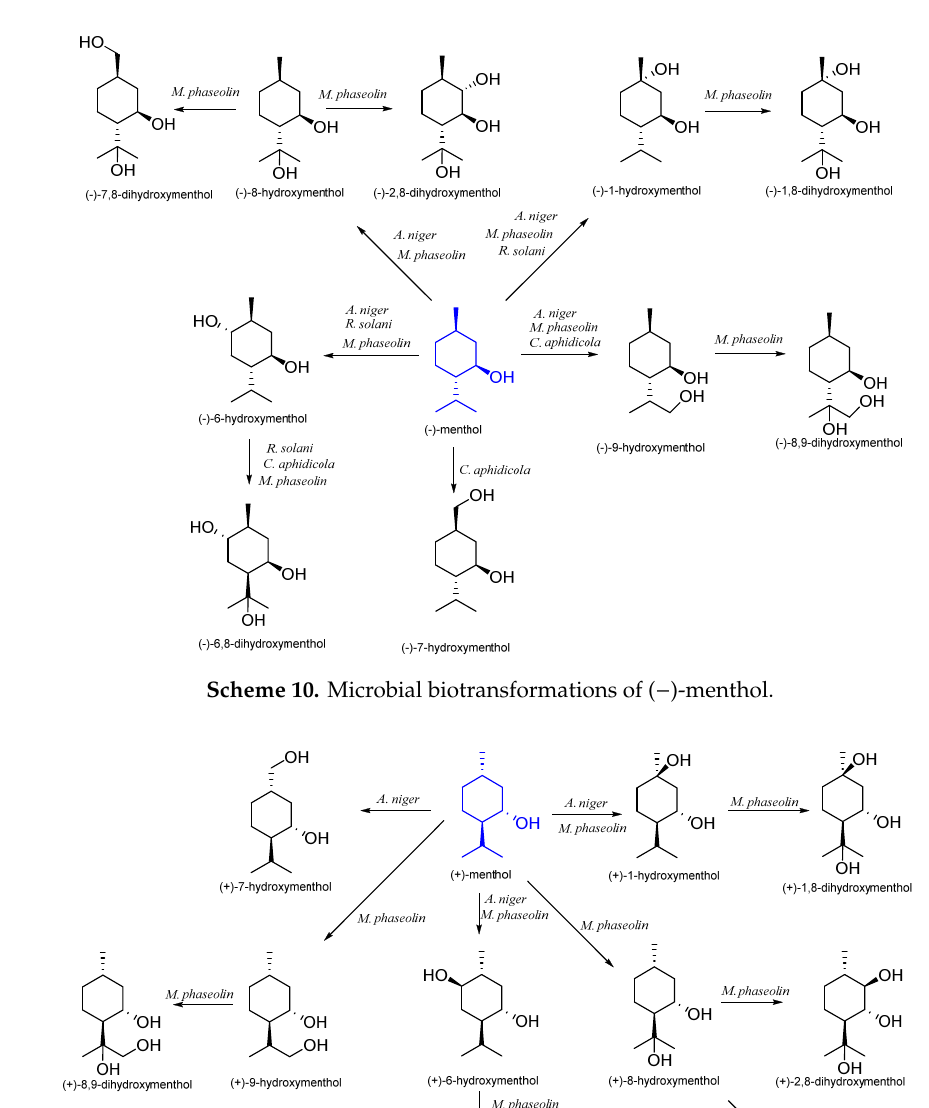
Scheme 10. Microbial biotransformations of ( −